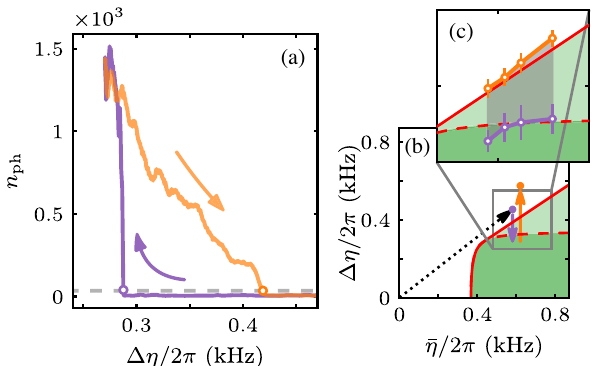
FIG. 4. Hysteresis at the boundary between the superradiant and the dissipation-stabilized normal phase. (a) Time trace of the intracavity photons in a single typical experimental realization, when crossing the boundary between the superradiant and the dissipation-stabilized normal phase in opposite directions. (b) Corresponding trajectory in the parameter space ð ¯ η ; Δ η Þ . The hysteresis is measured at constant ¯ η ; an artificial offset along ¯ η is introduced between the forward and backward path in the conceptual figure (b) for better visibility. The dashed arrow marks the preparation of the system within 6 ms in the dissipation- stabilized normal phase, starting from zero coupling. Each (down, up) sweep of Δ η across the bistability region (purple, orange) is a 3-ms-long S-shaped ramp. (c) Mapping the hysteresis region. Dots: phase boundary detected during the forward (purple) and backward (orange) path for different ¯ η . The positions of the boundaries are determined from the photon traces by setting a threshold of 36 mean intracavity photons, as indicated in (a) with the gray line. The data points shown in (c) are mean values of 12 – 18 realizations, with the error bars representing the standard deviation. As a guide to the reader, in the background of (b) and (c), the analytical phase diagram highlights the region of stable normal phase (white), stable superradiant phase (dark green), and bistability (light green). The theoretical boundaries are rescaled to the experimental data, with a single factor applied to both couplings. For this measurement, N ¼ 1 . 10 ð 8 Þ × 10 5 ,